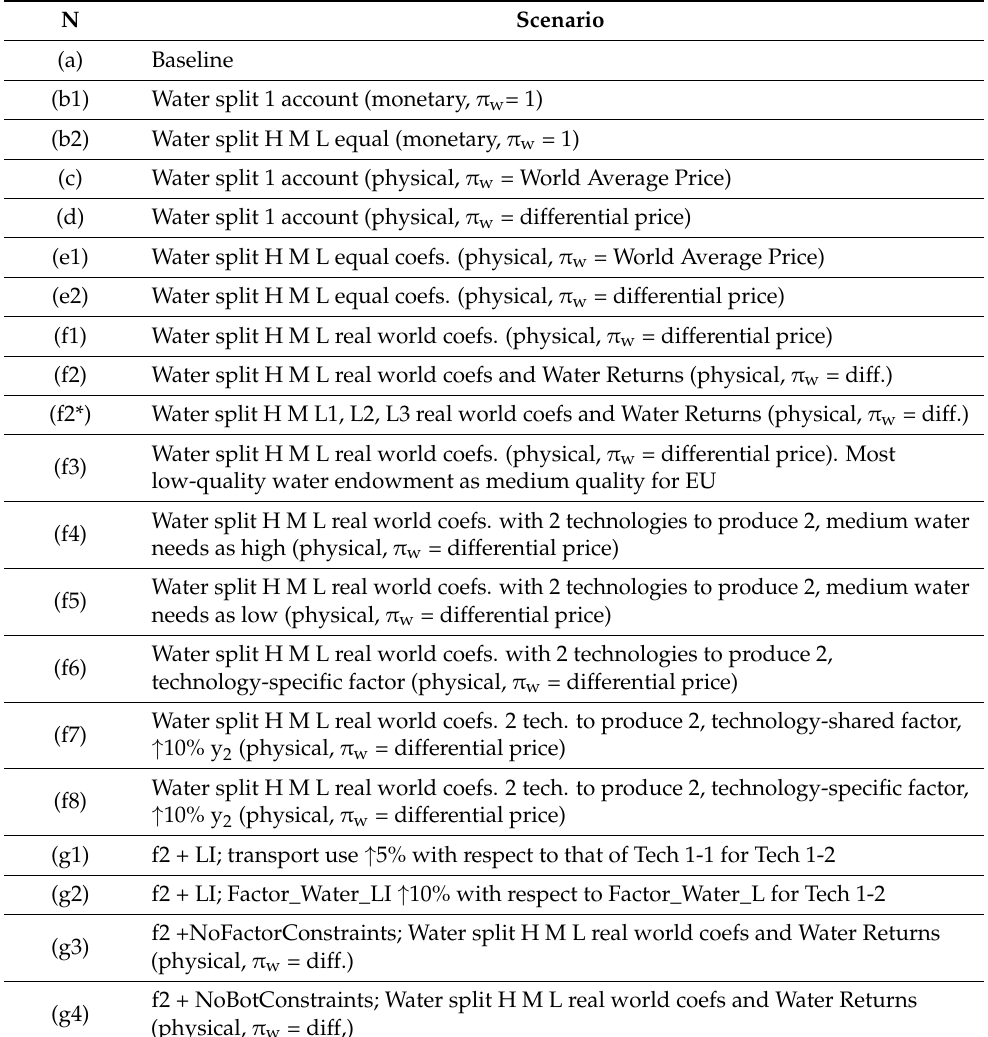
Table 5. Summary of